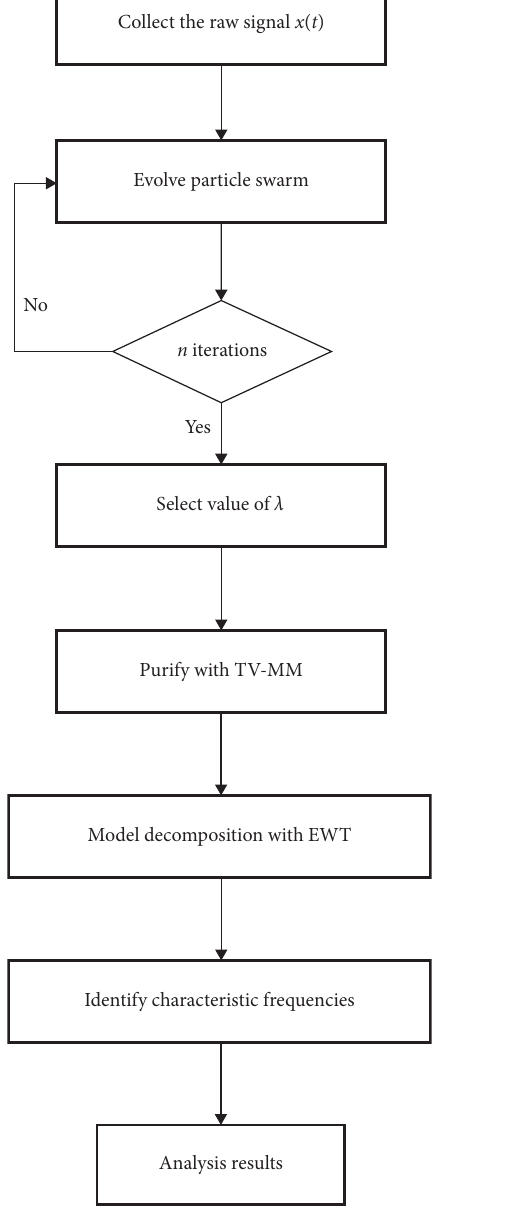
Figure 1: Processing flow diagram for the ensemble fault diagnosis method.